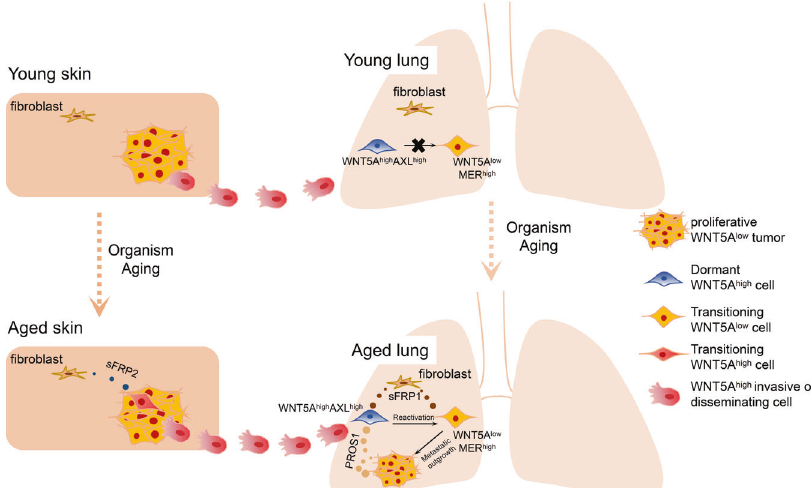
Fig. 1 Age-induced changes promote metastatic melanoma outgrowth. Aged skin fi broblasts promote melanoma cell dissemination from the primary tumor through sFRP2 secretion which activates WNT5A. Aged lung fi broblasts secrete sFRP1 to reduce WNT5A expression of disseminated melanoma cells, thus promoting metastatic melanoma outgrowth from dormancy through AXL-MER dormancy-reactivation